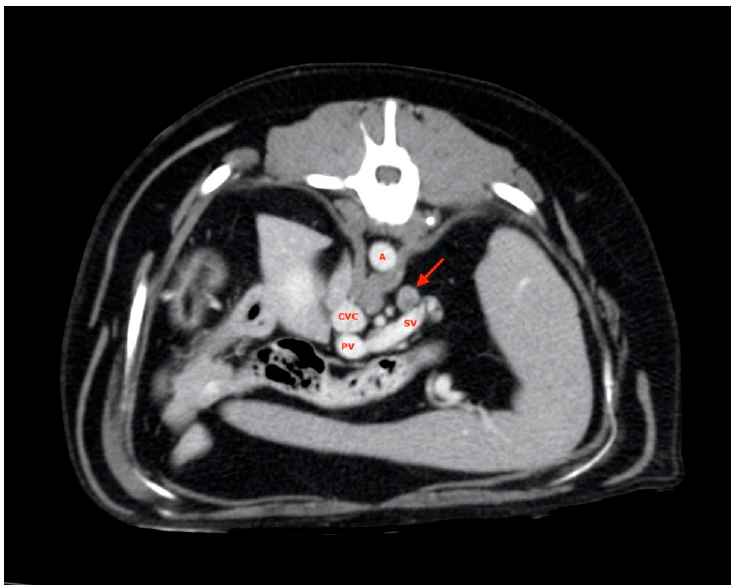
Figure 3. Splenic lymph node (red arrow). A, aorta; CVC, caudal vena cava; PV, portal vein; SV, splenic vein.